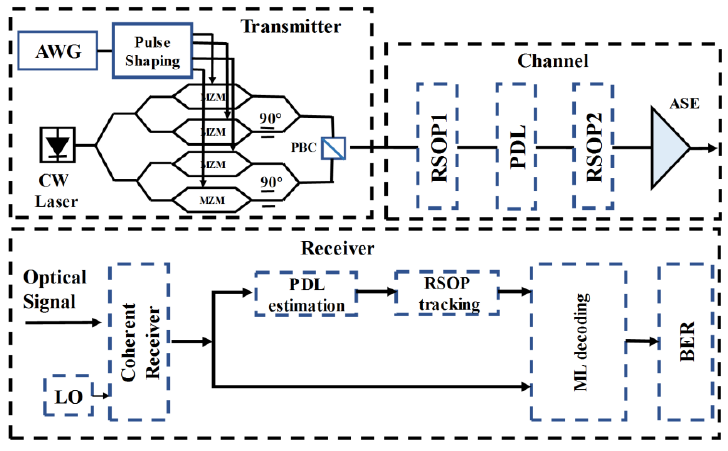
Figure 6. Numerical simulation system platform.